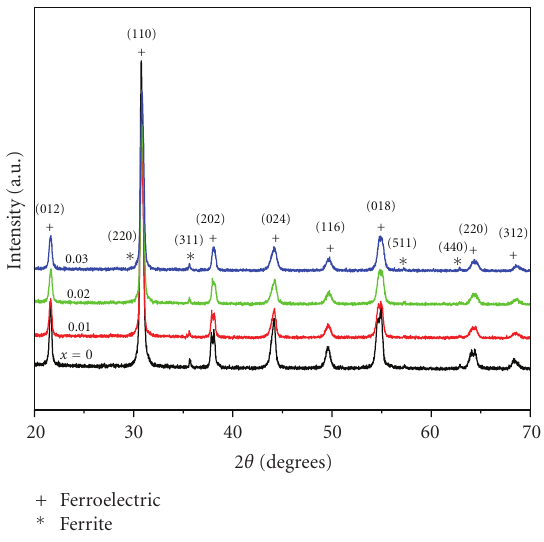
Figure 1: XRD patterns for x = 0, 0.01, 0.02, and 0.03.